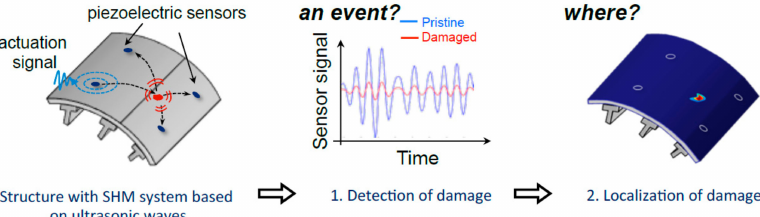
Figure 7. Diagram for damage detection with guided waves (reproduced with permission from